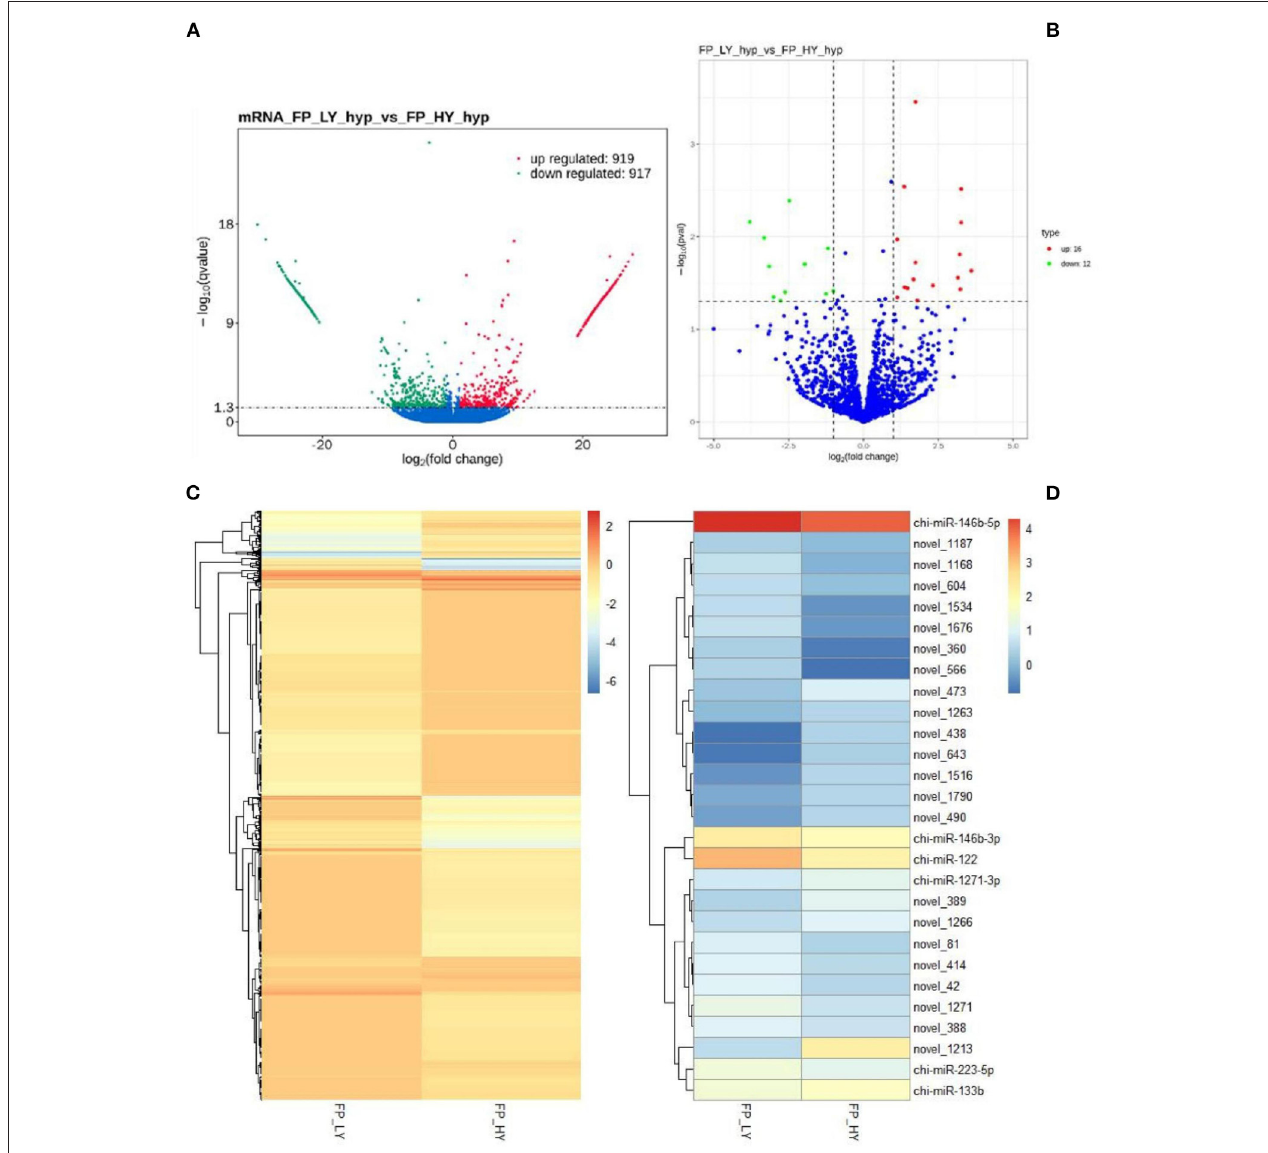
FIGURE 3 | DEGs and DEMs analyses. Volcano plot of identified genes (A) and miRNAs (B) in FP-HY vs. FP-LY, where red and green represent up- or down-regulation, respectively. Heat maps showing the expression intensity of 1,836 DEGs (C) and 28 DEMs (D) in FP-HY vs.